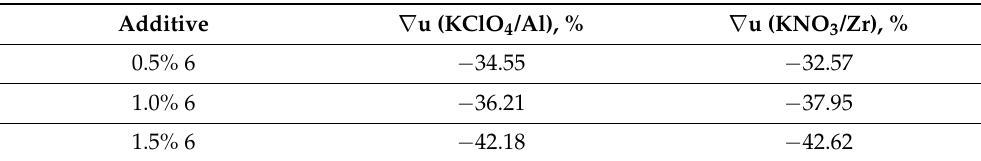
Table 4. Burning rate as a function of the content of 6 in the pyrotechnic mixtures used in the present